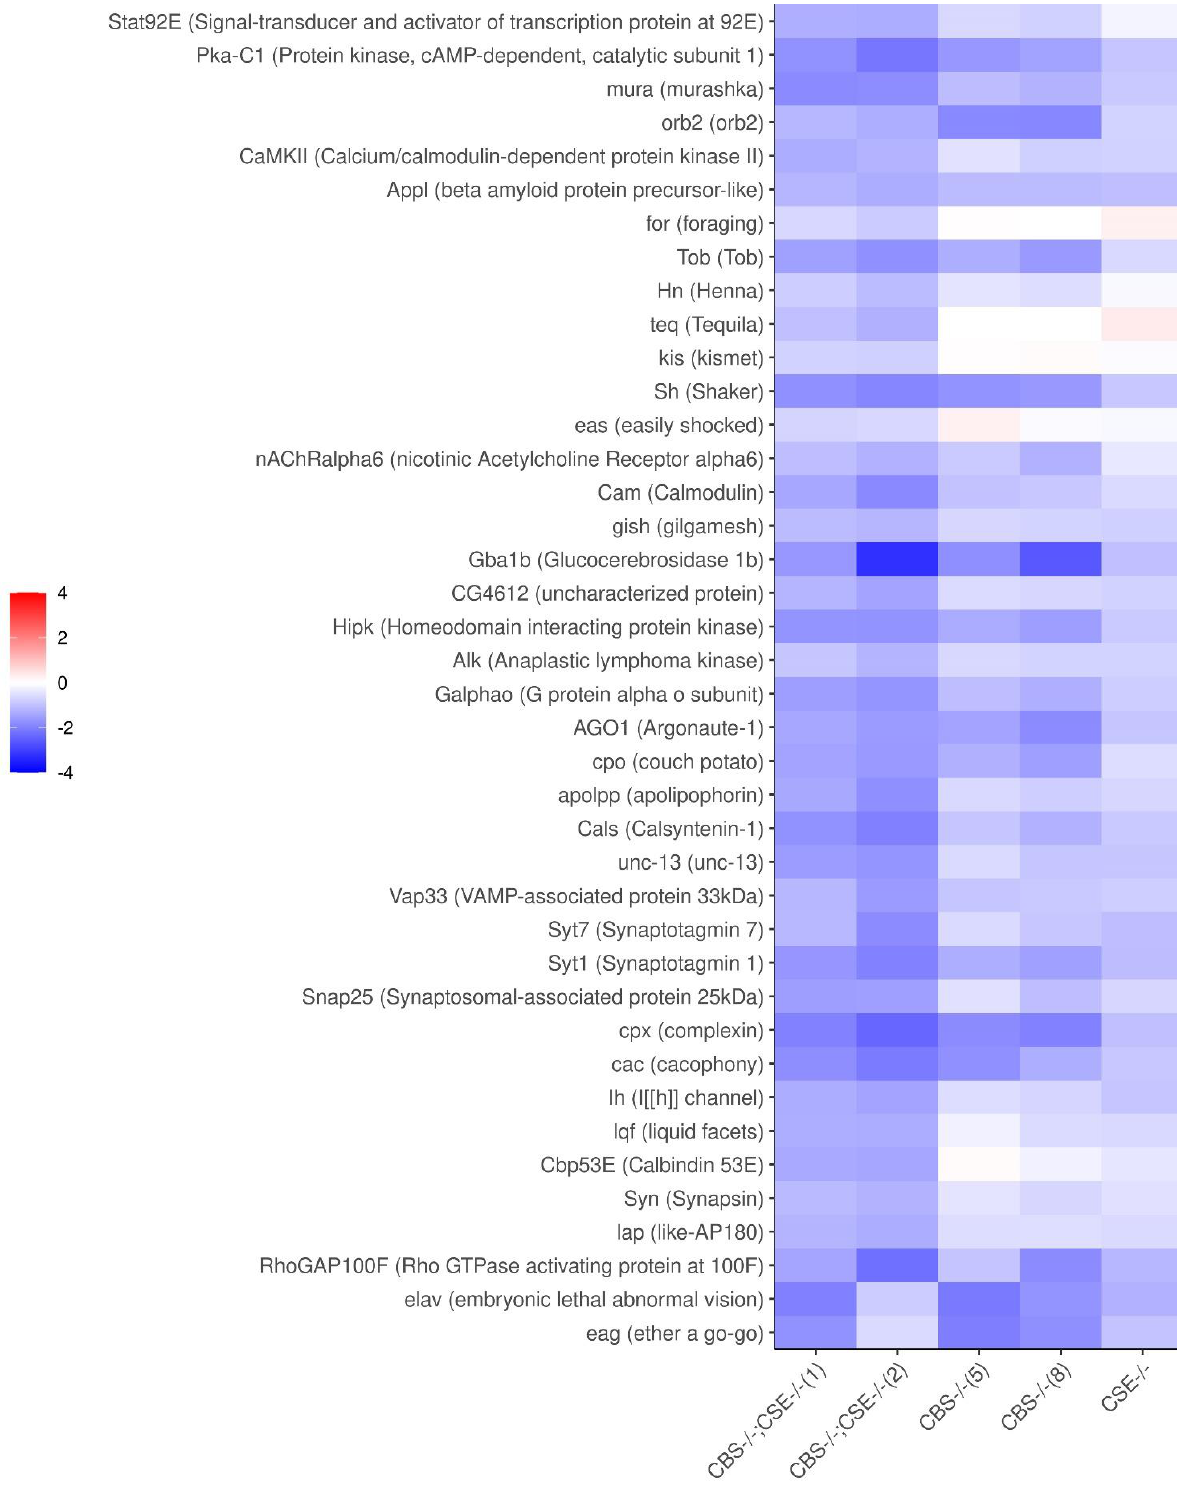
Figure 7. Heat map for down-regulated genes involved in learning and memory, cognition, synapse organization, and signaling in the strains with deletions. (Genes with FDR < 0.05 in at least one comparison were considered significant). All comparisons were with the control strain (58492). Several genes with altered expression revealed by transcriptome analysis (i.e., glucosi- dase beta acid ( GBA1 ) gene, Tequila ( Teq ) gene, and Argonaute-1 ( Ago1 )) were studied